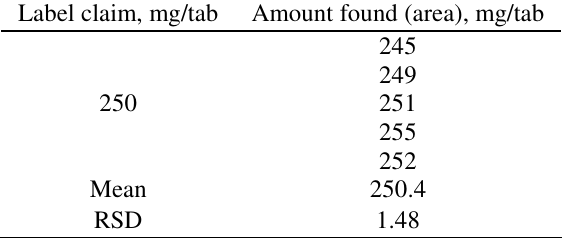
Table 1 . Estimation of cefprozil in